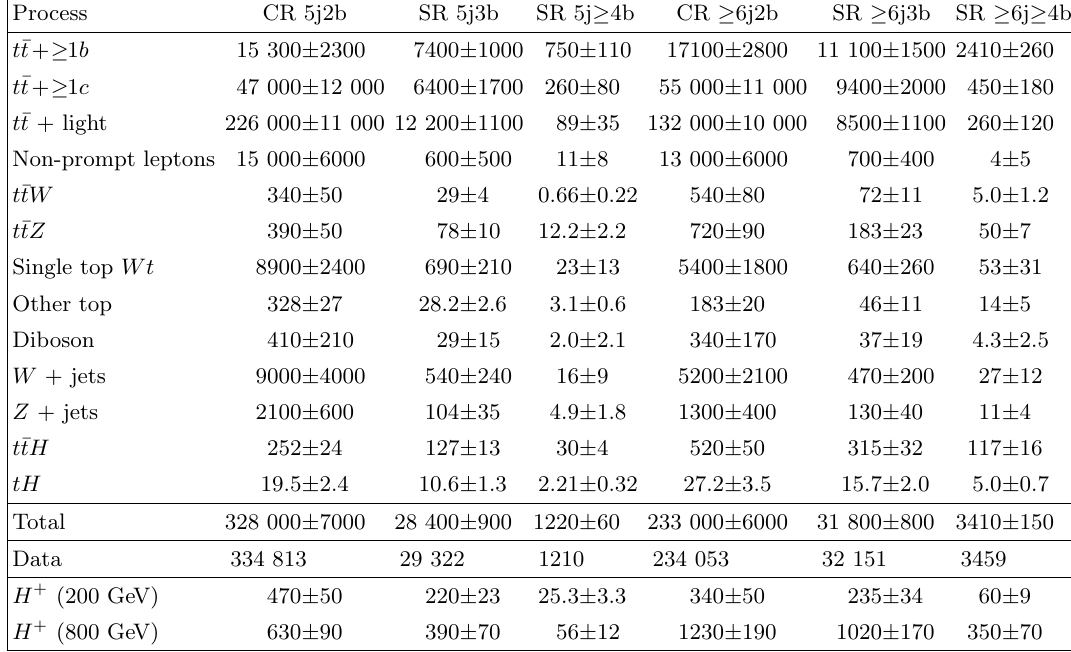
Table 3. Event yields of the SM background processes and data in all categories of the ‘ +jets (cid:12)nal state, after the (cid:12)t to the data under the background-plus-signal hypothesis ( m The expected event yields for the H + signal masses of 200 GeV and 800 GeV are shown with pre-(cid:12)t uncertainties and assuming a cross-section times branching ratio of 1 pb. The quoted uncertainties include both the statistical and systematic components. The uncertainties take into account corre- lations and constraints of the nuisance parameters. ‘Other top’ includes contributions from Zt as well as s - and t -channel single top